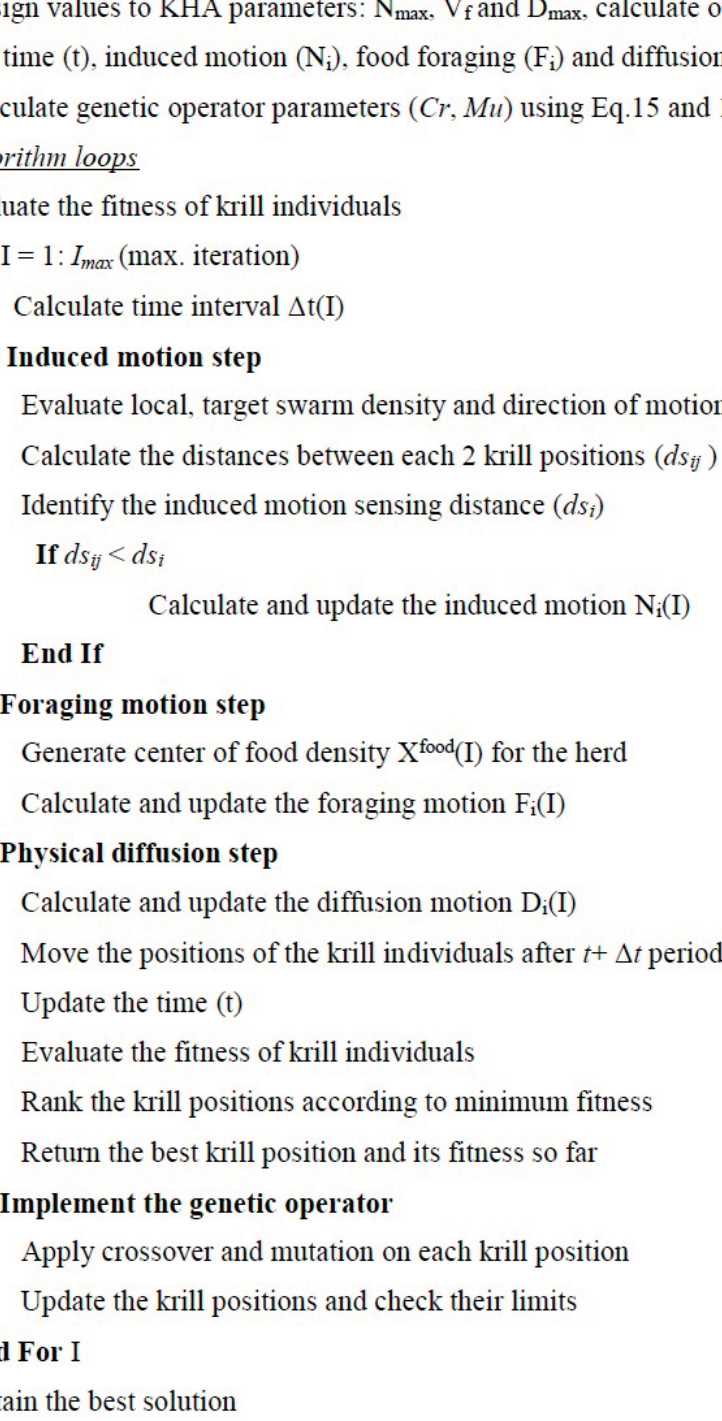
Figure 2. The pseudo-code of the Krill Herd Algorithm